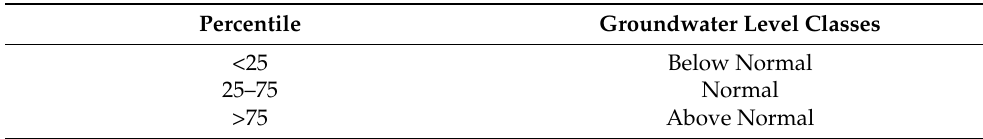
Table 1. Groundwater level categorization to determine